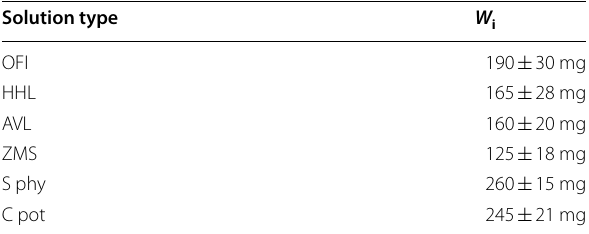
Table 1 The initial average stones weight